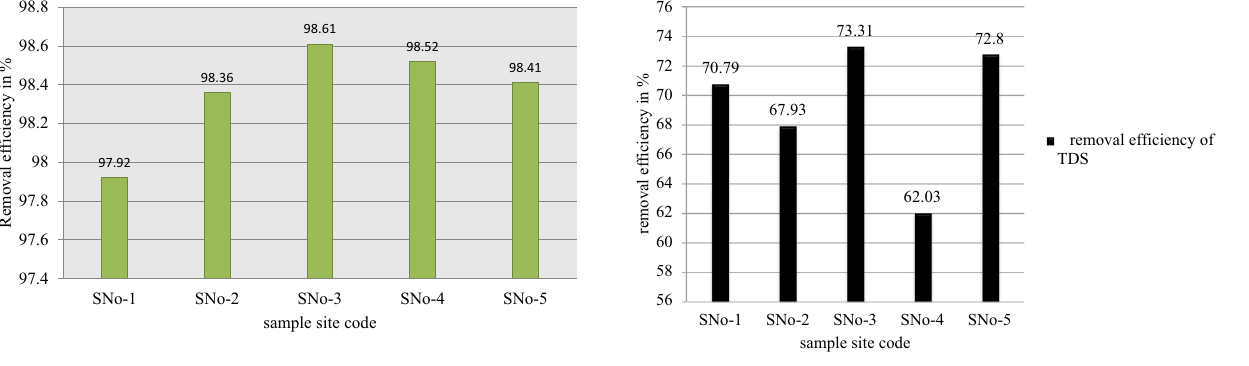
Fig. 6 TDS removal efficiency of chlorination in sampling site